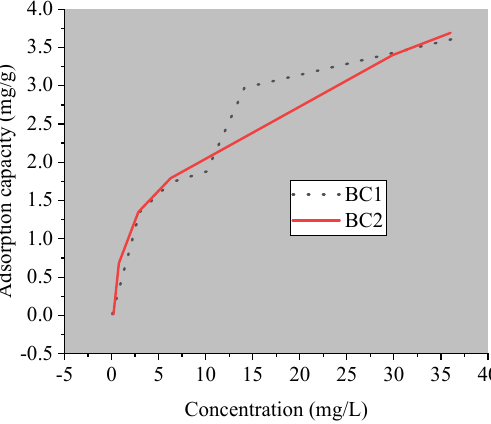
Figure 4. TC removal effect of pure BC at different TC concentrations.